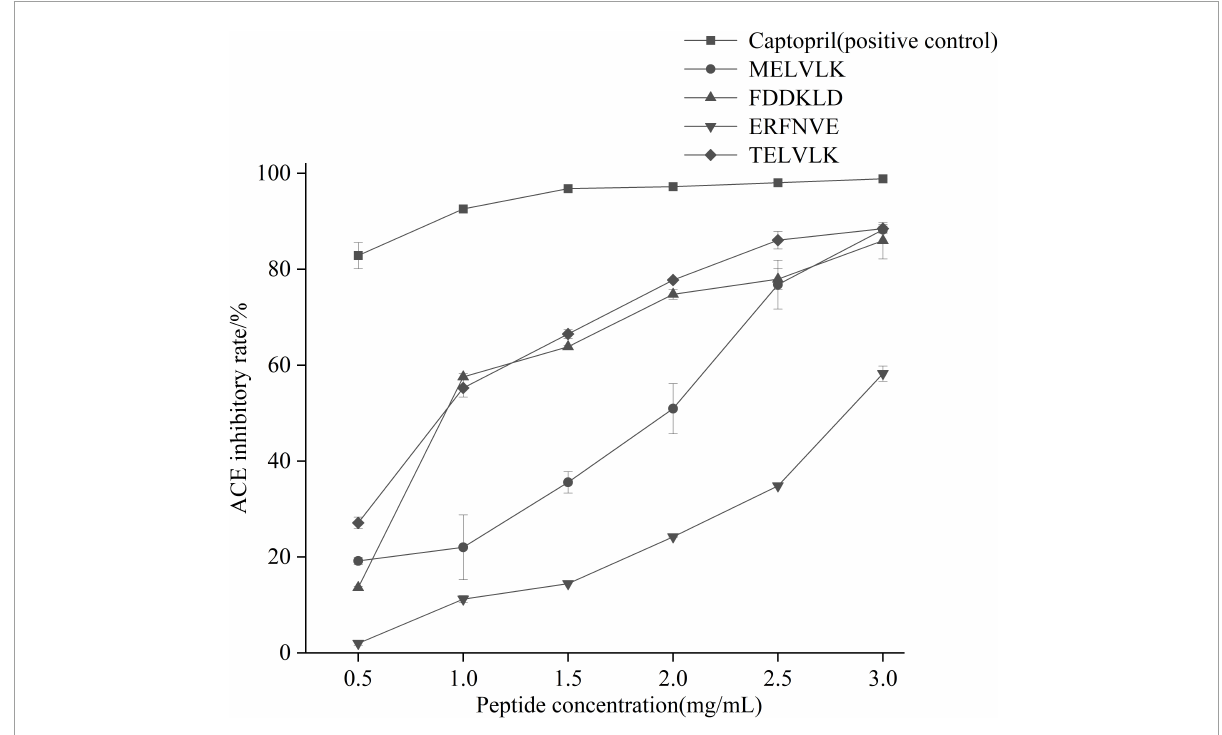
FIGURE8 Angiotensin-I converting enzyme inhibitory activity of synthetic peptides.